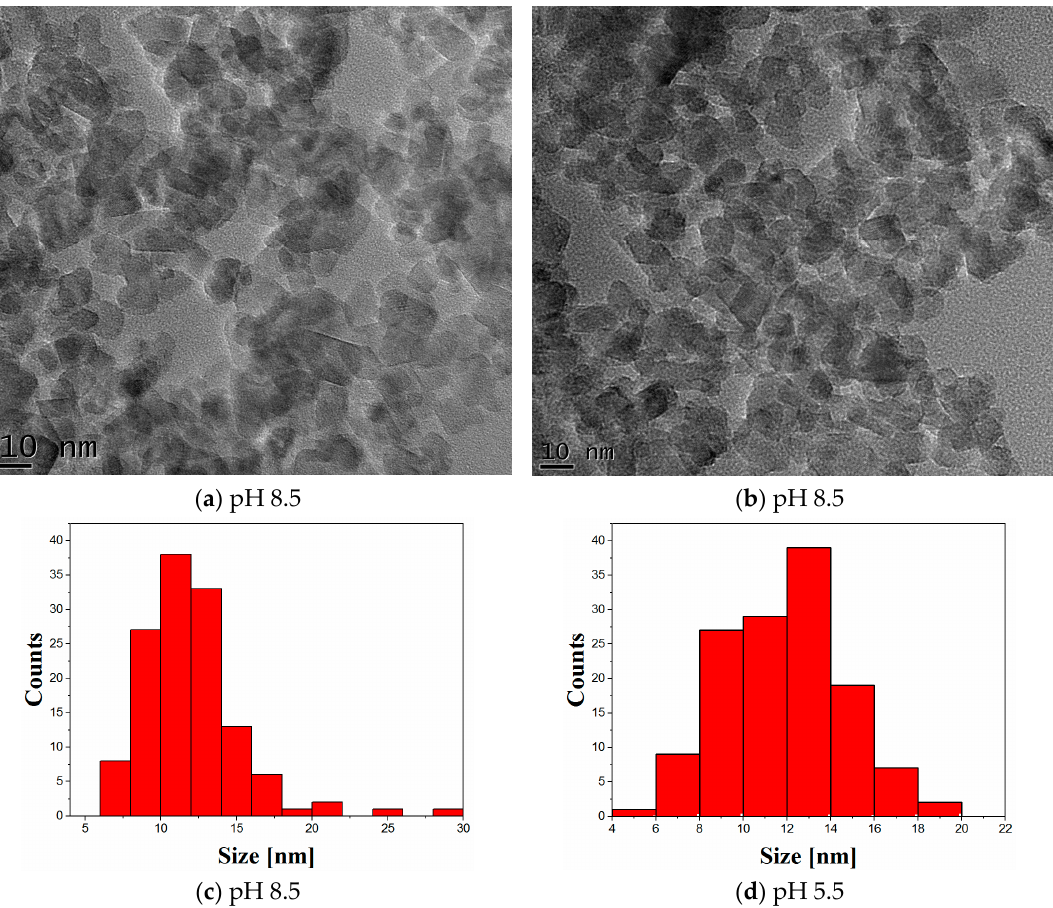
Figure 2. Transmission electron microscopy (TEM) images ( a , b ) of TiO 2 -1% Fe–N photocatalysts and their corresponding size distribution ( c , d ) for: pH 8.5 (photocatalyst 1) and pH 5.5 (photocatalyst 2).